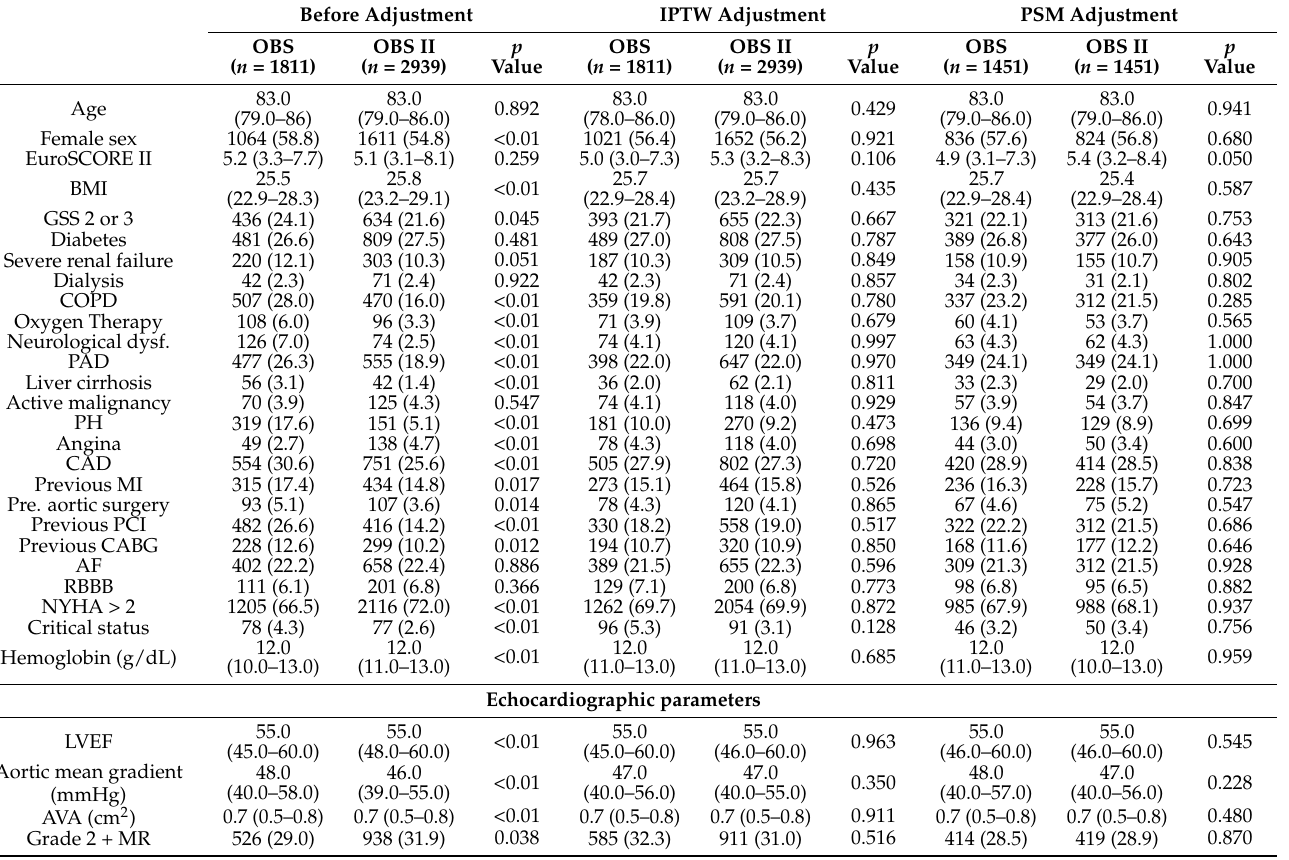
Table 1. Baseline characteristics of population before and after baseline covariates